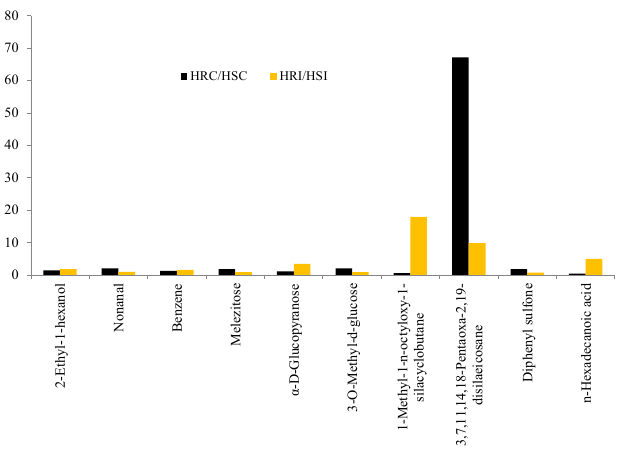
Figure 5. Fold change analysis of common metabolites. Accumulation was significant for 1-Methyl-1-n-octyloxy-1-silacyclobutane (18-fold), 3,7,11,14,18-Pentaoxa-2,19-disilaeicosane (10-fold), and n-Hexadecanoic acid (5-fold) in HR under infected